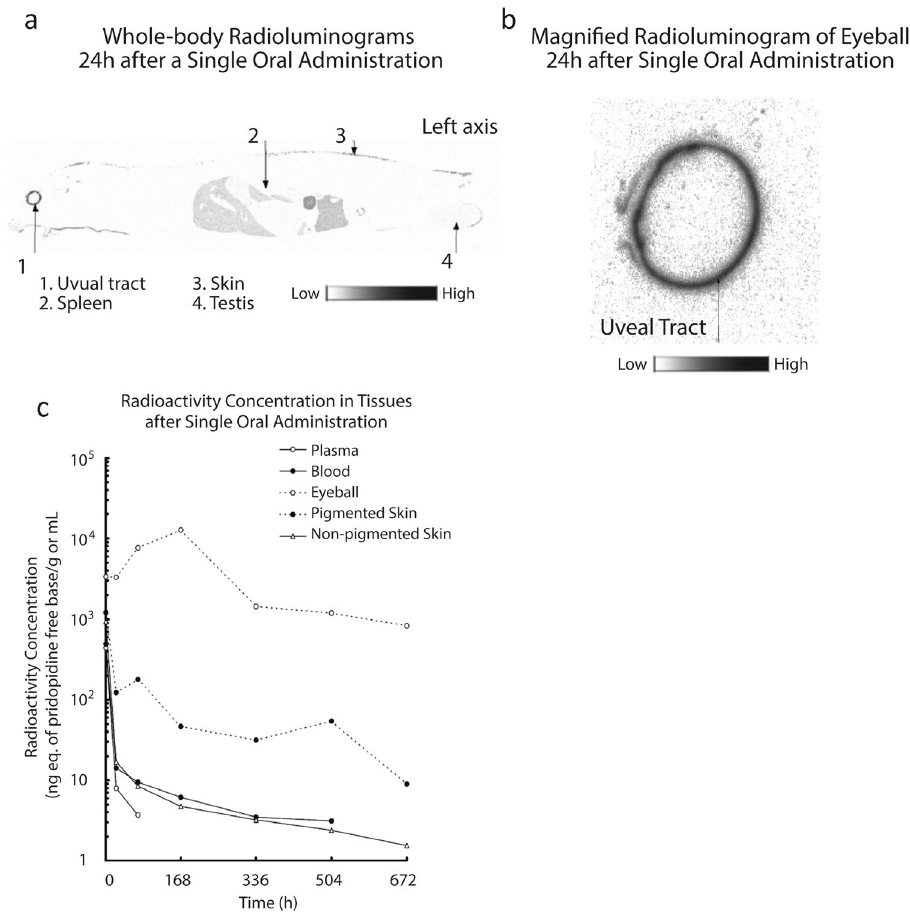
Figure 2. Pridopidine binds strongly to melanin. Food-deprived male rats were given 3 mg/kg of 14 C-pridopidine free base, and radioactivity levels assayed at specific time points. ( a ) After 24 h, a whole-body radioluminogram was acquired, showing high levels in the highly pigmented uveal tract. ( b ) Magnified image of the uveal tract. ( c ) Relative levels of radioactivity in different tissues over time. Each data point is the values of one animal. A total of 7 animals was